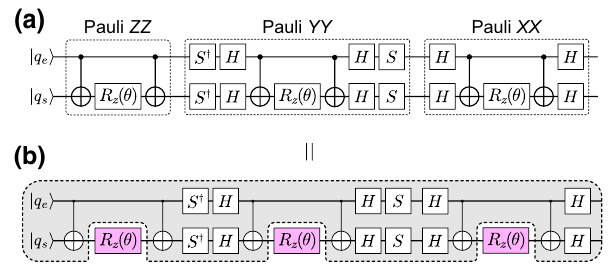
FIG. 5. (a) The decomposition of a p SWAP gate into Clifford and R z gates. (b) The decomposition results in a process com- posed of Clifford gates, with sampling operations R z (θ) acting on the system. For θ = π/ 4, the sampling operations are T